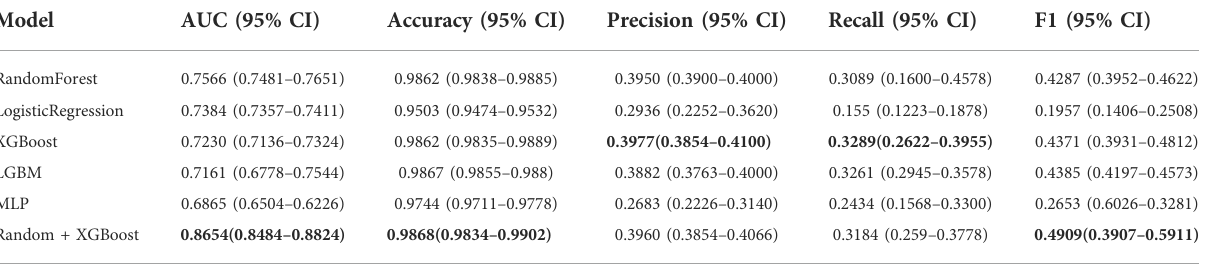
TABLE 3 Performance of classi fi cation models including selected features.